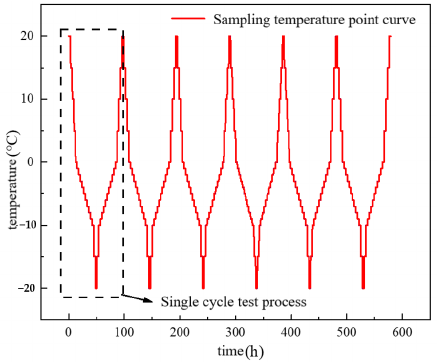
Figure 3. Temperature gradient in the